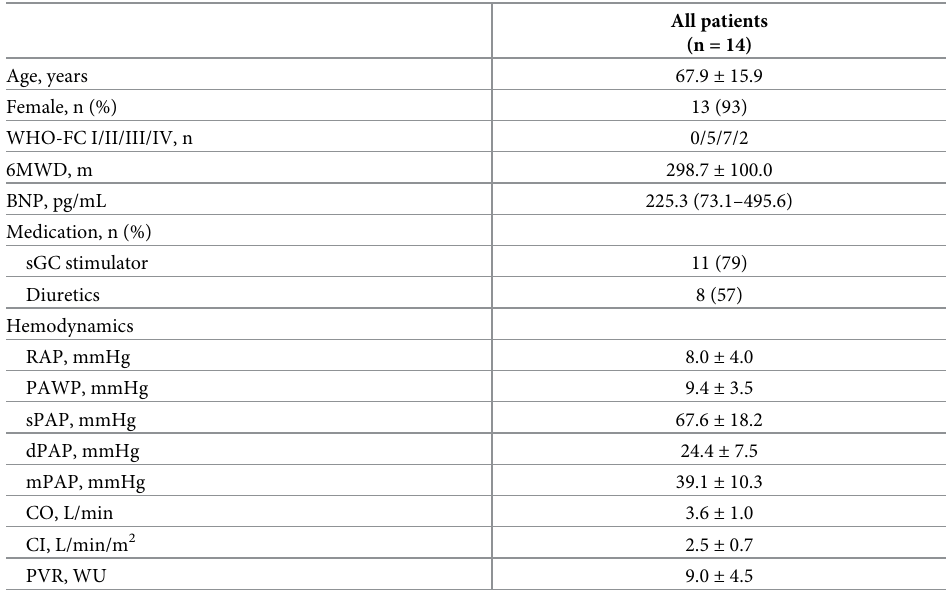
Table 1. Baseline population